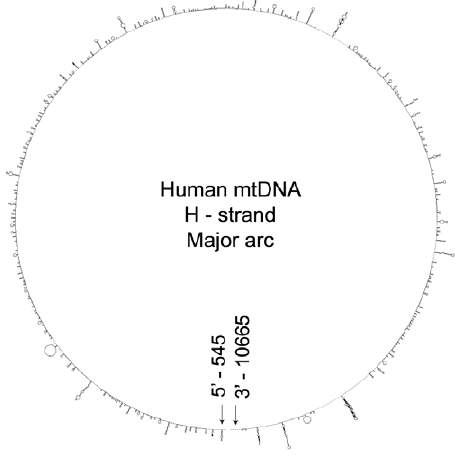
Figure 2. Stem-loop (SL) motifs in human mitochondrial genome. Abundance and distribution of predicted SL motifs in single-stranded human mtDNA heavy strand major arc. The positions 545 to 10665 correspond to the H-strand sequence from the end of D- loop till the beginning of L-strand origin of replication respectively. The minimum free energy folded structure is depicted in circular form.